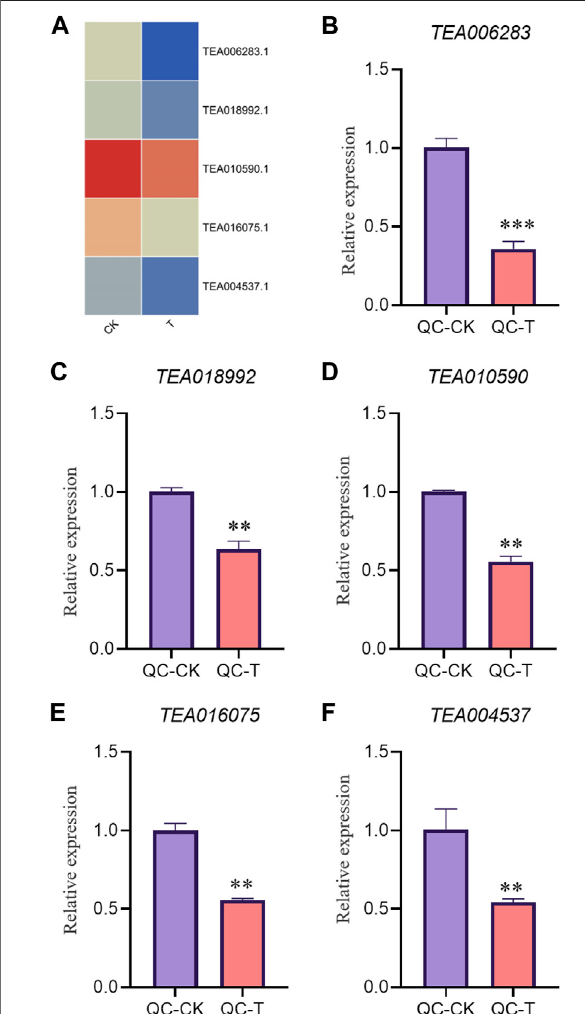
FIGURE 9 | QC-CK&QC-T Comparison of down genes expression patternbetweenRNA-SeqandqRT-PCRresults.Thegeneexpressionvalues were normalized to the Actin gene. The purple column represents the results of drought treatment for 0 days, and the orange red column represents theresultsofdroughttreatment for20 days.CK:Cuttingsamplestreatedwith drought for 0 days, T:Cuttingsamples treated withdrought for 20 days. ** p < 0.01, *** p < 0.0001.